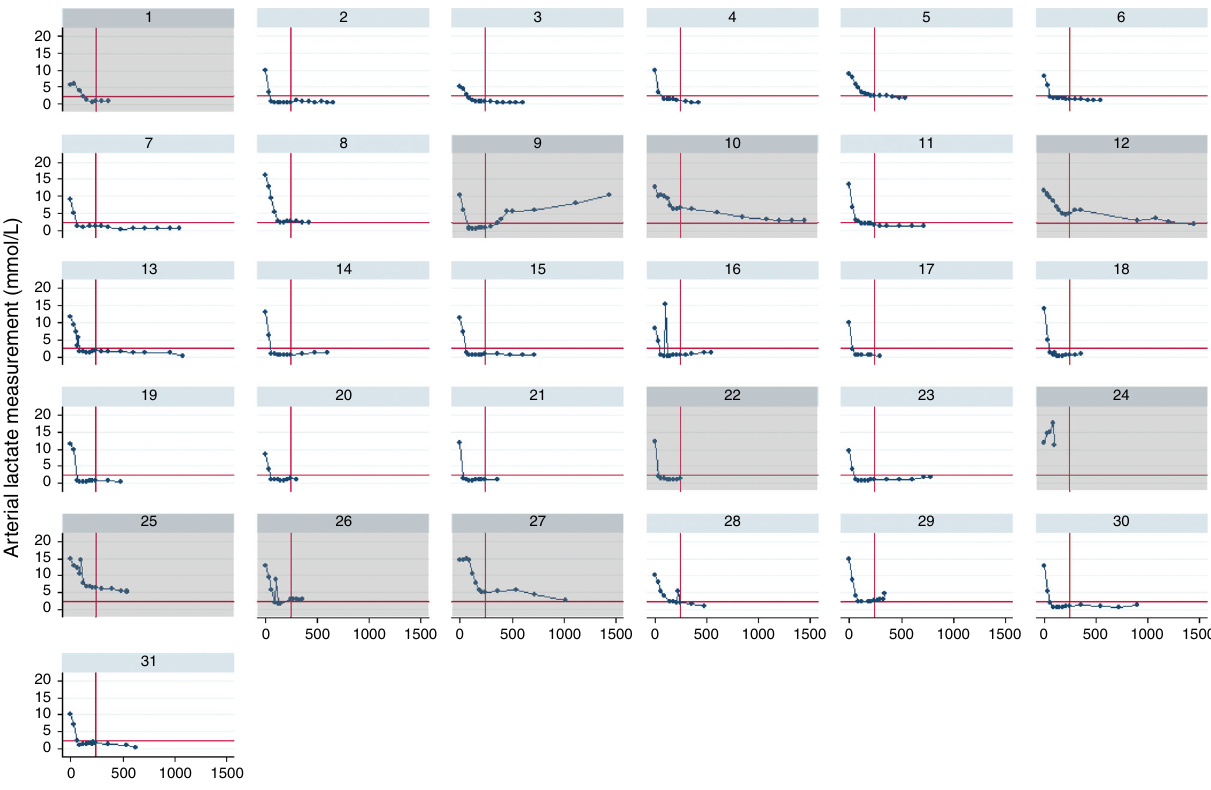
Fig. 4 The study liver lactate clearance. Plots of individual liver arterial lactate clearance measured during the NMP perfusion, showing transplantation eligibility thresholds with red lines for lactate levels less than or equal to 2.5 mmol/L. Graphs with grey shading designate livers that were not transplanted. Liver number 22 was from a donor that was unexpectedly diagnosed with a cancer following organ